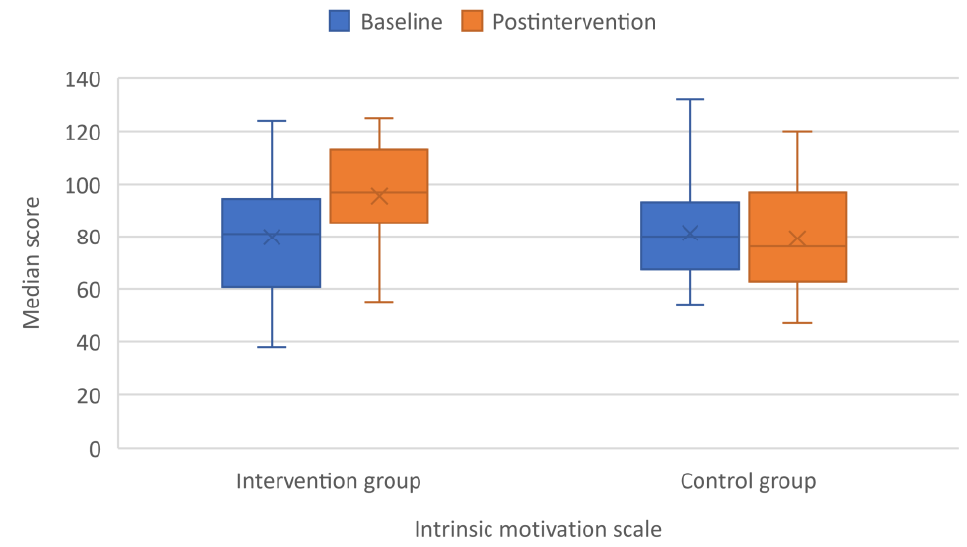
Figure 4. Boxplot graph depicting median scores of Intrinsic Motivation scale (IMS) at baseline and after intervention.